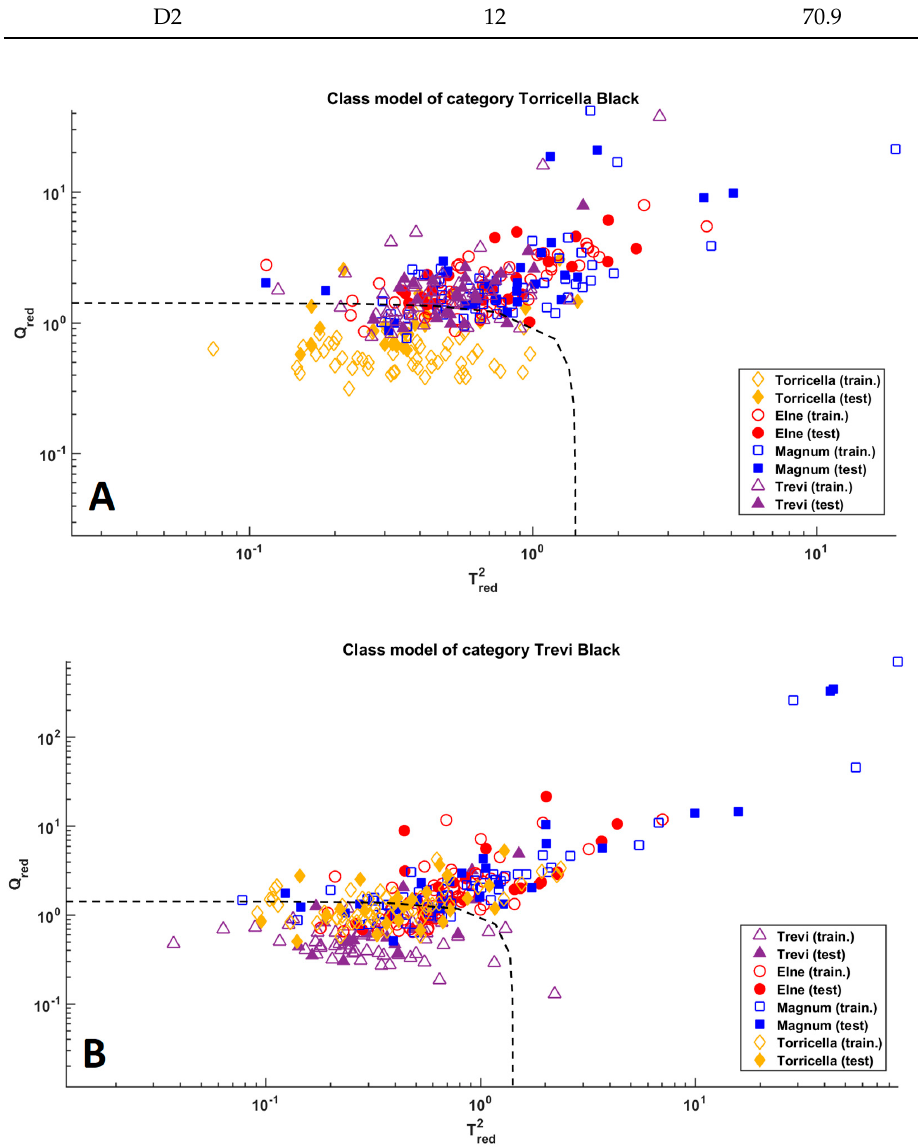
Figure 5. SIMCA analysis. Plot ( A ): model of class Torricella Black; Plot ( B ): model of class Trevi Black. Legend: class Magnum—blue squares; class Torricella Black—yellow diamonds; class Elne—red dots; class Trevi Black—purple triangles. Filled and empty symbols represent calibration and validation samples, respectively. The dashed line delimits the acceptance region.